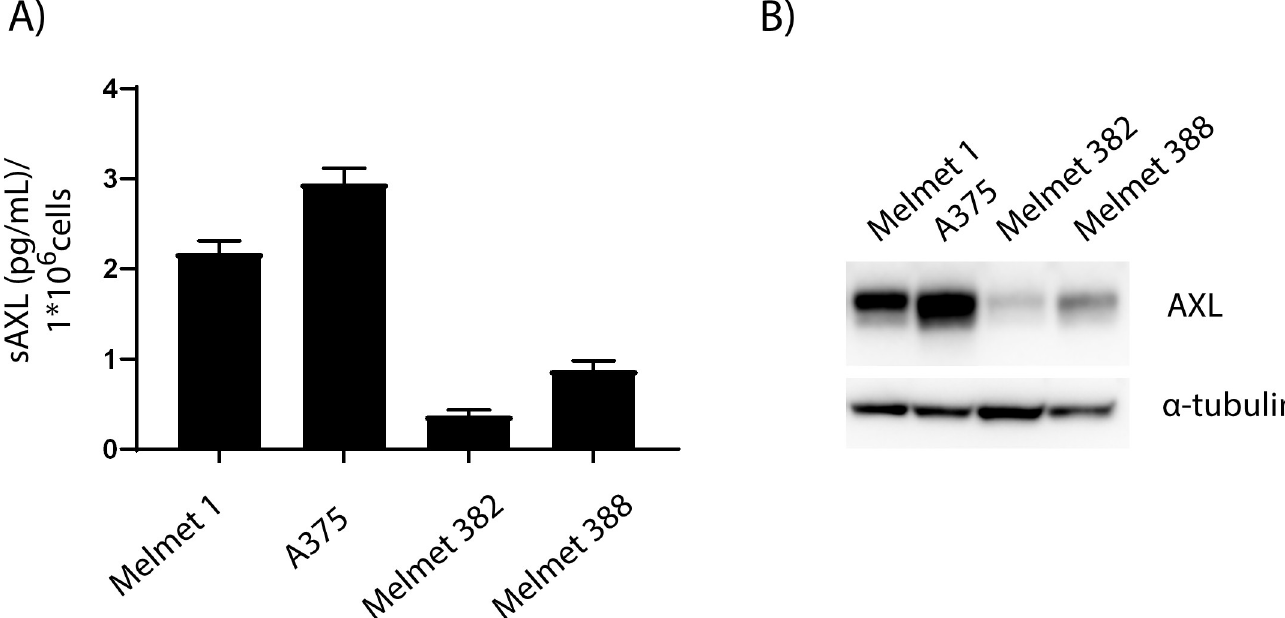
Fig 1. sAXL mirrors AXL levels in cell lines. A) Levels of sAXL as measured by ELISA in the media of melanoma cell lines Melmet 1, A375, Melmet 382 and Melmet 388 related to 1 � 10 6 cells. Error bars indicate SEM (n = 3) and B) Corresponding cellular AXL levels as measured by immunoblot. α -tubulin was used as loading